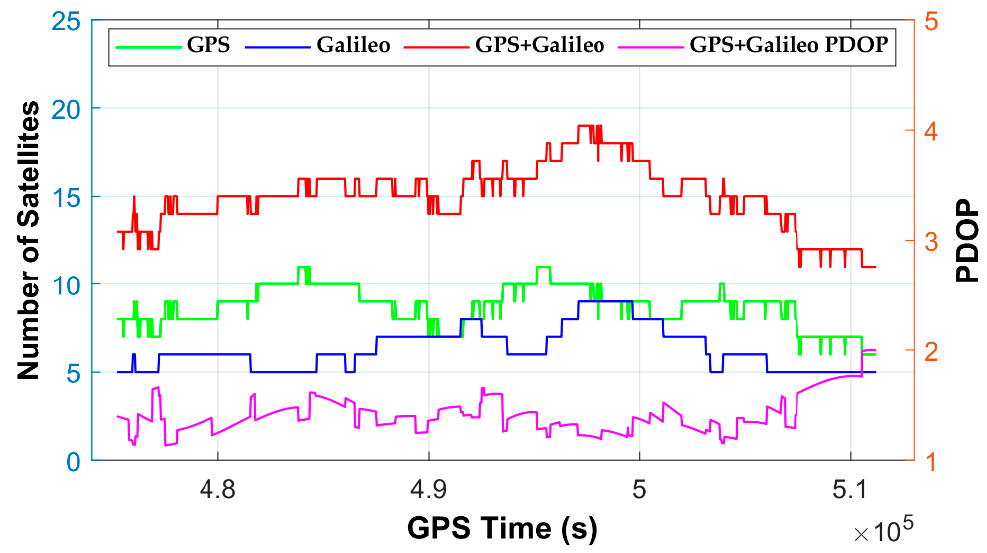
Figure 1. Observational equipment and condition.